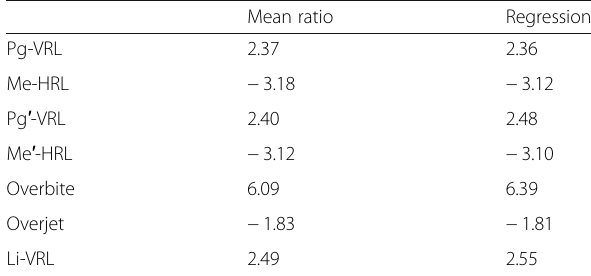
Table 5 Prediction of selected variables according to mean ratios and regression equations for 3 mm of molar intrusion